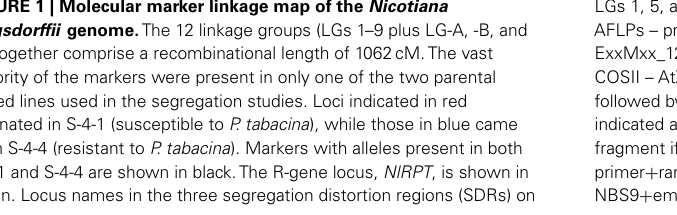
LGs 1, 5, and 9 are shown in boldface. Locus nomenclature: AFLPs – primer combination followed by fragment size in bases (e.g., ExxMxx_123); SSRs – locus names begin with A, B, C, D, GIS, or KTRDC; COSII – AtXg followed by a five digit number; ISSR loci – U825 or U826 followed by the fragment in bases; ISSR/SCAR – cloned fragment size indicated as a four digit number, followed by the size of the scored fragment if different (e.g., U826_1900/700);TRAP loci – gene-specific primer + random primer followed by the fragment size in bases (e.g., NBS9 +